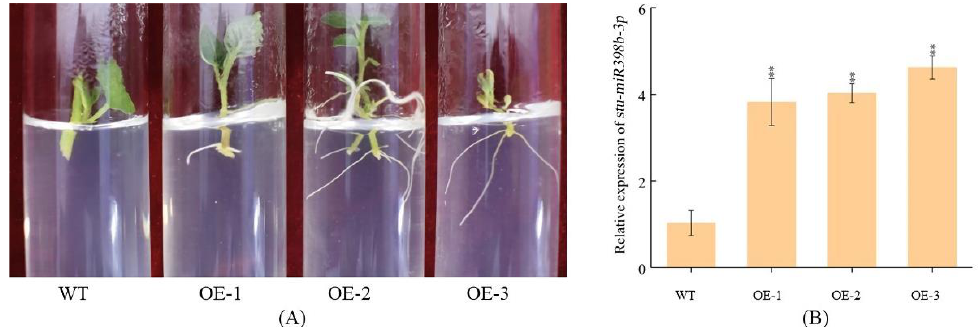
Figure 3. ( A ) Rooting selection of stu-miR398b-3p overexpression plants. After 7 days in the selective medium, OE-1, OE-2, and OE-3 rooted while WT did not. The test tube plantlets of 9 WT lines with biological and technical duplication did not root in the rooting selection medium. The test tube plantlets of 9 WT lines with biological replicates and technical replicates did not root in selection medium. The 9 test-tube plantlets of the 3 OE lines all gradually rooted within 7 days, and there were no plants that did not root. ( B ) Identification of stu-miR398b-3p overexpression lines by qRT- PCR. Three independent biological samples of three technical replicates for qRT-PCR analysis. Each column represents the mean values ± SE ( n = 3; ** p < 0.01). WT: wild type; OE-1, OE-2 and OE-3: stu-miR398b-3p overexpression lines.